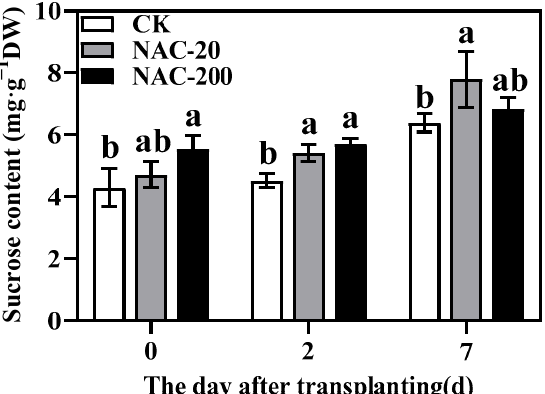
Figure 6. Effects of different concentrations of NAC on sucrose content. CK, 0 µ m; NAC-20, 20 µ m; NAC-200, 200 µ m. Data are means ± SD ( n = 3). The different letters following average values indicate significant difference (Duncan, p < 0.05).